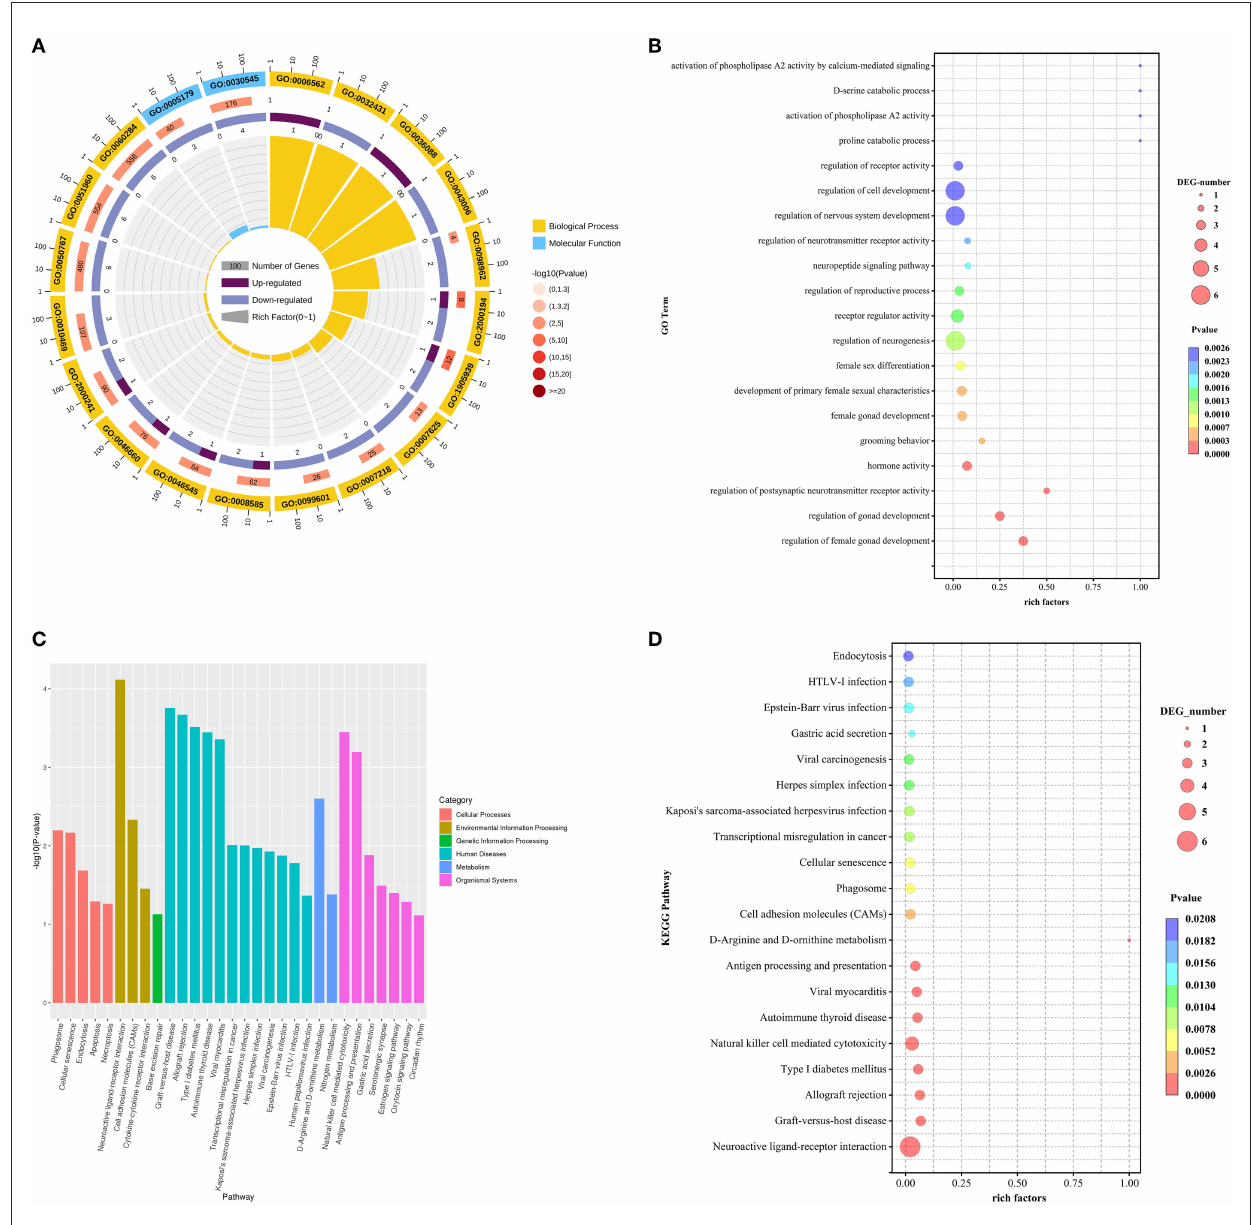
FIGURE3 (A–D) GO and KEGG analyses of DE mRNAs between HFG and LFG in the hypothalamus.